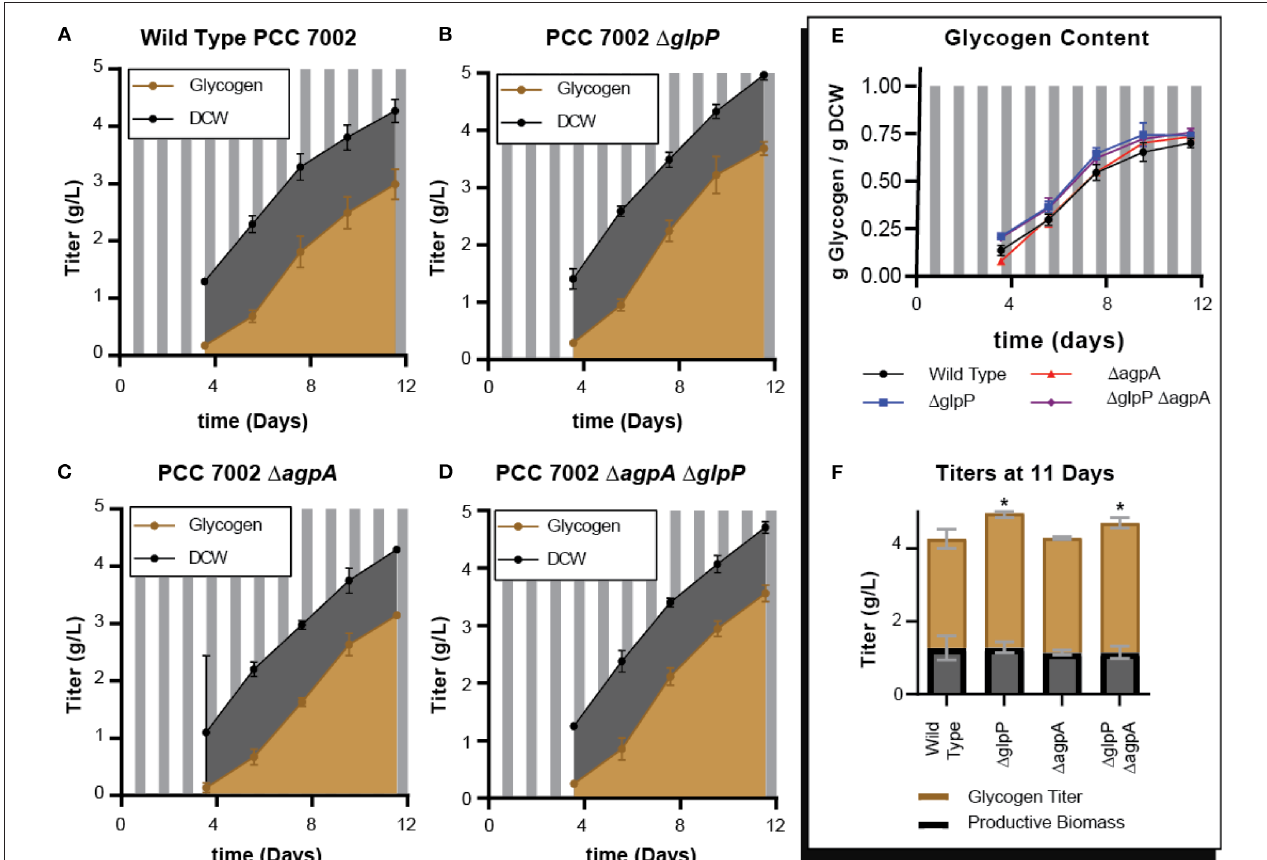
FIGURE 4 | Biomass and glycogen production by PCC 7002 strains grown under diurnal light conditions (see Figure 3A ) in media A. This experiment investigates the value of knocking out linear glycogen phosphorylases in the glycogen catabolism pathway under more restrictive diurnal conditions. (A–D) Show the accumulation of glycogen and productive biomass over time. Gray areas represent incubation without light. (E) Shows the fractional glycogen content. In each strain the content approached 75% by the end of the culture. (F) Shows the breakdown of total DCW as glycogen (brown) and productive biomass (black). The 1 glgP